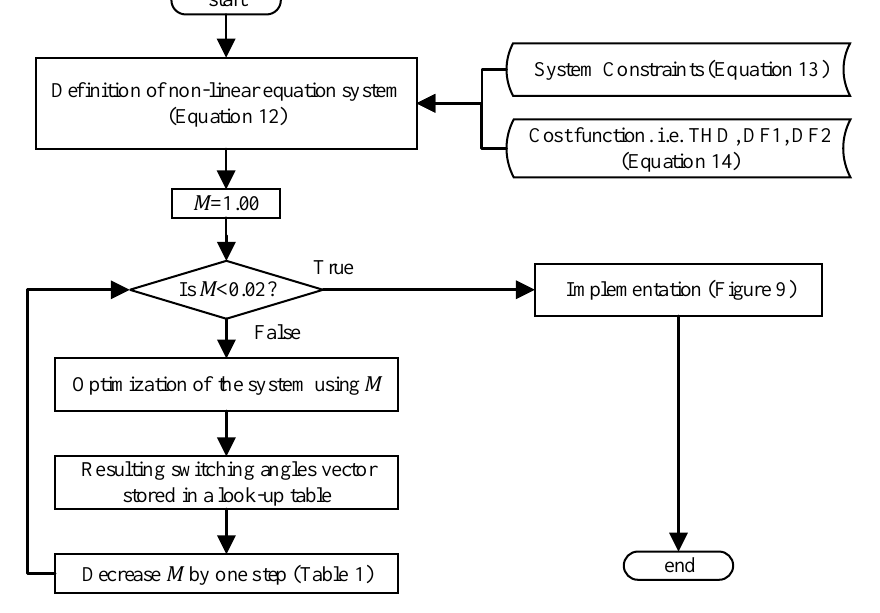
Figure 4. SHE modulation flowchart. Table 1. Switching angles for SHE technique ( M =